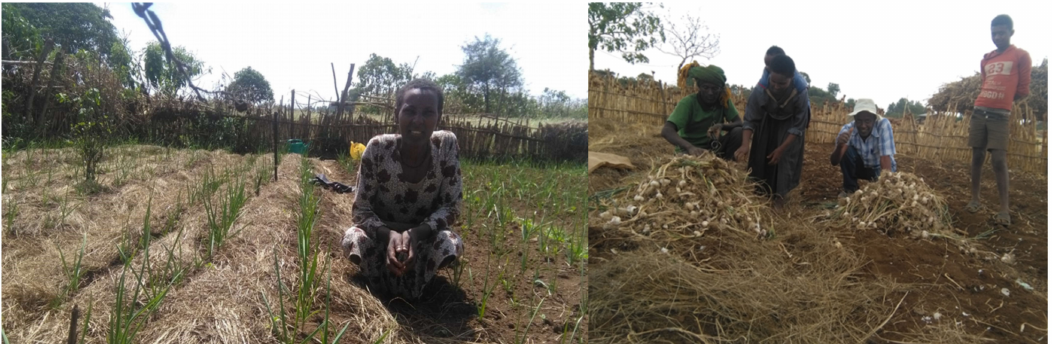
Figure 2. Drip irrigation combined with CA under garlic crop ( Allium sativum ) in Dengeshita experimental site, Ethiopia